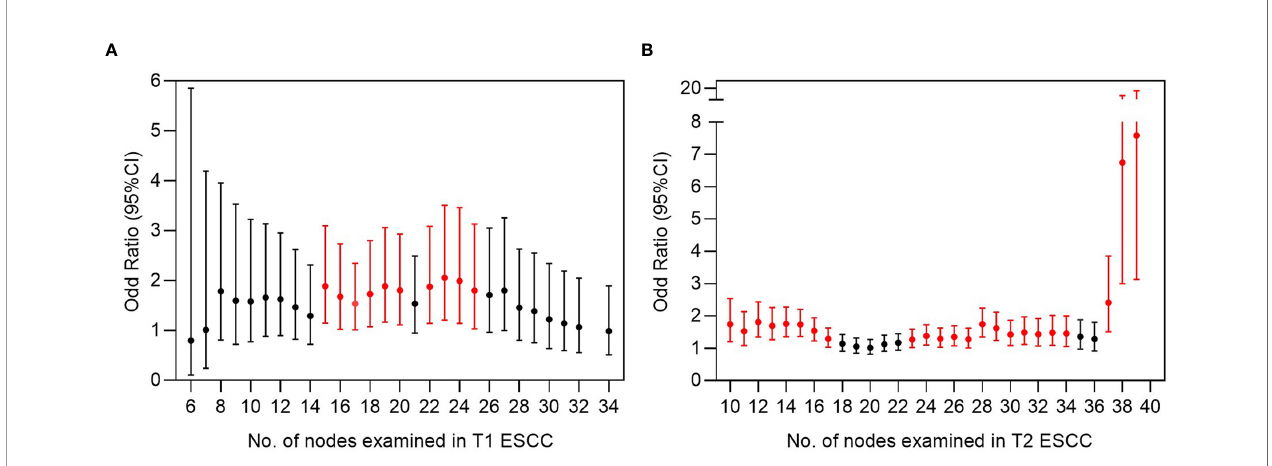
FIGURE 5 | Risk analysis for fi nding a positive lymph node based on multiple cut-off points of examined lymph nodes in (A) T1 and (B) T2 ESCC. Odds ratio represents the risk of positive fi nding on the right side panel of cut-off point compared to the left side panel of cut-off point. Bars in red indicate statistically signi fi cant differences by chi-square